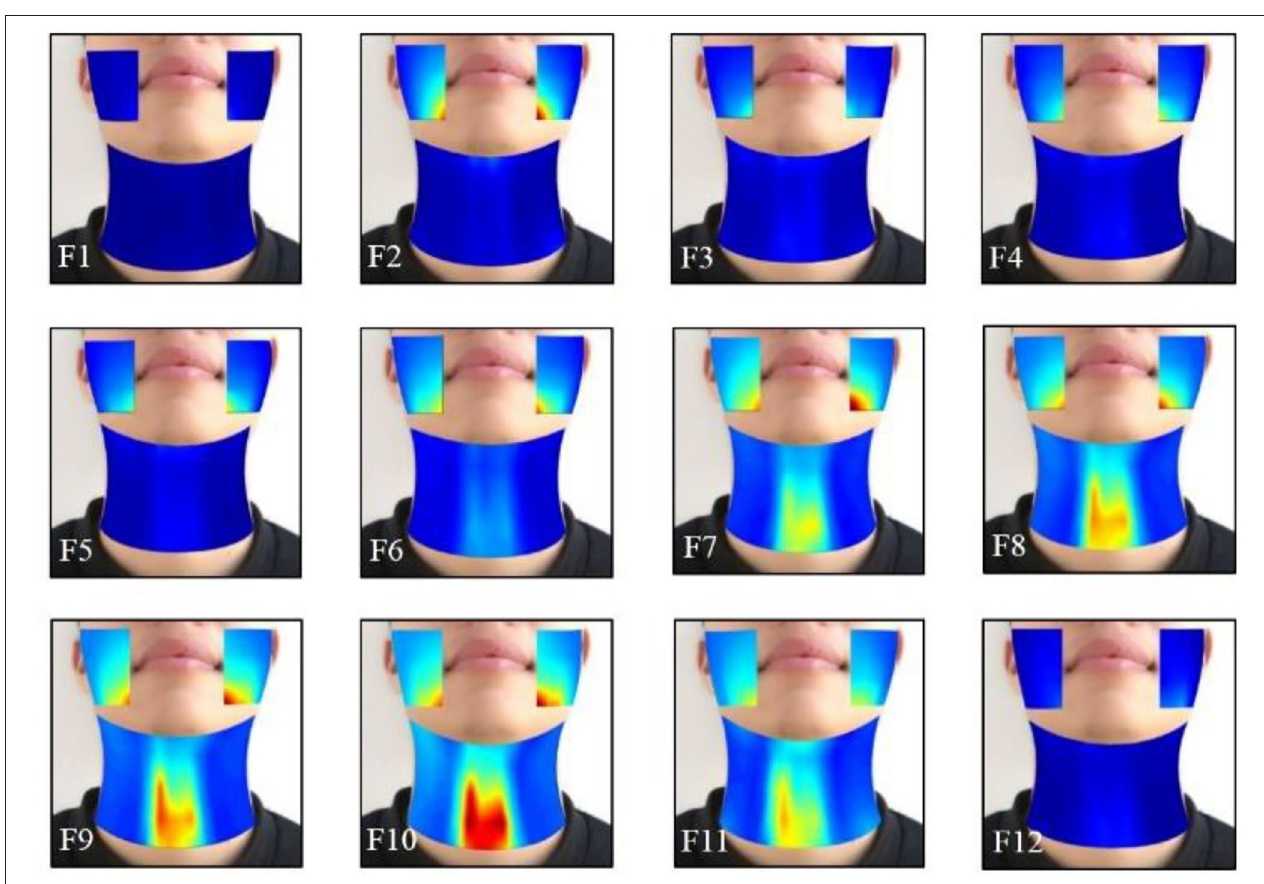
FIGURE 7 | The averaged HD sEMG energy maps of the facial and neck muscles during the phonating vowel [i:] with a pitch